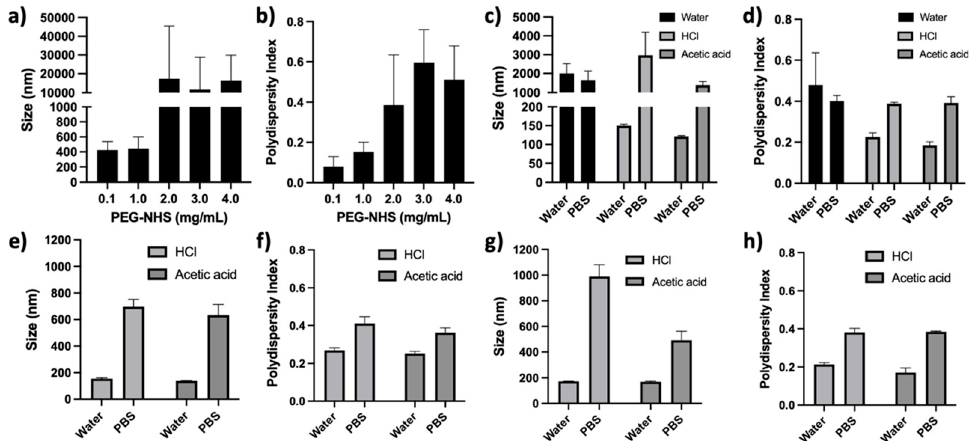
Figure 4. Post-functionalization of Zein nanoparticles (NPs) in varying experimental conditions: ( a ) size of Zein NPs at a PEG-N-hydroxysuccinimide (NHS) concentration between 0.1 and 4.0 mg/mL; ( b ) polydispersity of Zein NPs at a PEG-NHS concentration between 0.1 and 4.0 mg/mL; ( c ) size of Zein NPs post functionalized with 3.0 mg/mL PEG-NHS in an unbuffered system adjusted directly with HCl or acetic acid; ( d ) polydispersity of Zein NPs post-functionalized with 3.0 mg/mL PEG-NHS in an unbuffered system adjusted directly with HCl or acetic acid; ( e ) size of Zein NPs post-functionalized in 5% DMSO with 3.0 mg/mL PEG-NHS in an unbuffered system adjusted directly with HCl or acetic acid; ( f ) polydispersity of Zein NPs post-functionalized in 5% DMSO with 3.0 mg/mL PEG-NHS in an unbuffered system adjusted directly with HCl or acetic acid; ( g ) size of Zein NPs post-functionalized in 10% EtOH with 3.0 mg/mL PEG-NHS in an unbuffered system adjusted directly with HCl or acetic acid; and ( h ) polydispersity of Zein NPs post-functionalized in 10% EtOH with 3.0 mg/mL PEG-NHS in an unbuffered system adjusted directly with HCl or acetic acid.